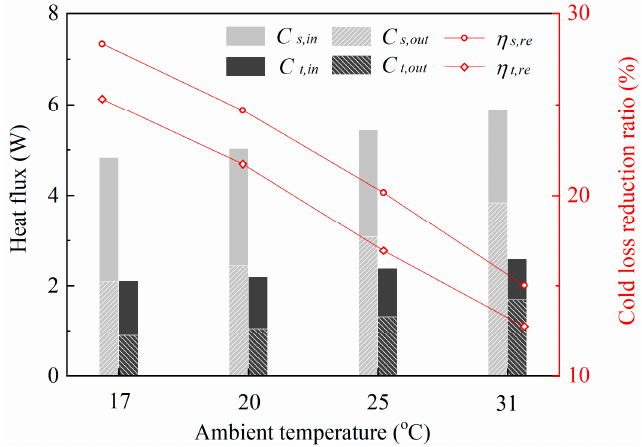
Figure 6. Cold loss comparison between side and topside freezer walls at various ambient temperatures.